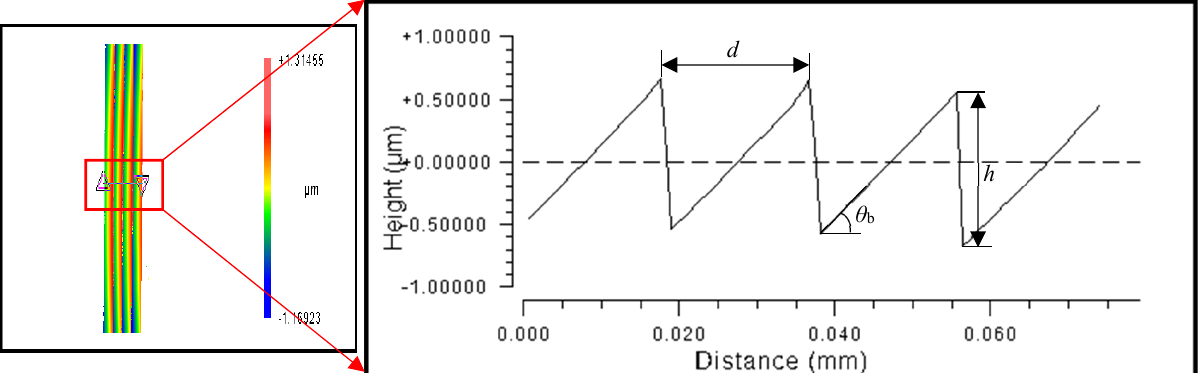
Figure 11. Measurements for grating period, grating height, and blaze angle of blazed grating. Table 4. Dimensions and roughness measurements of convex spherical blazed grating elements.